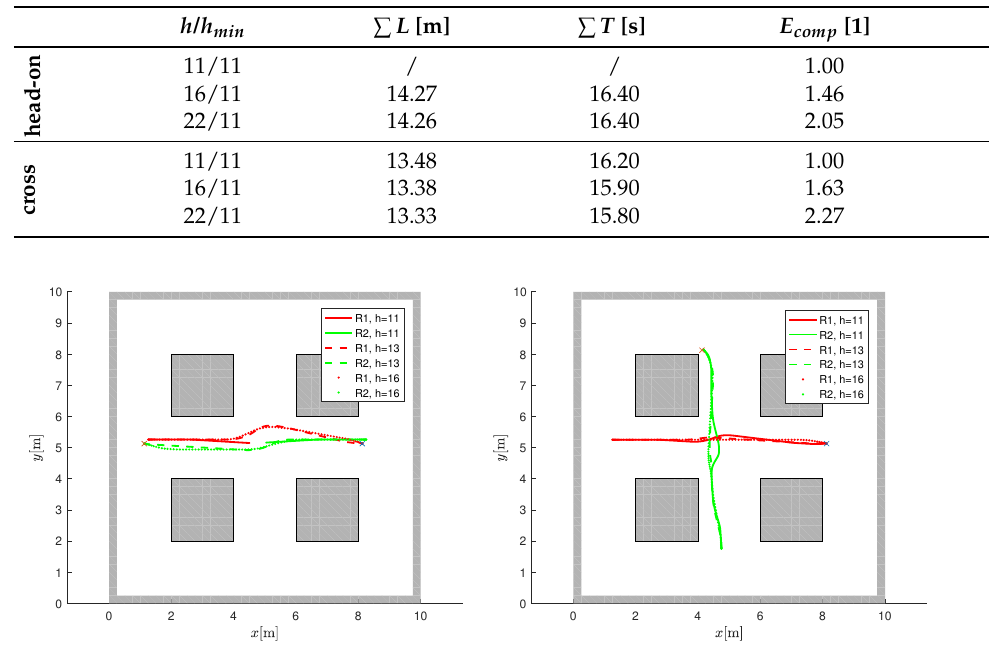
Table 2. Performance at variable horizon.